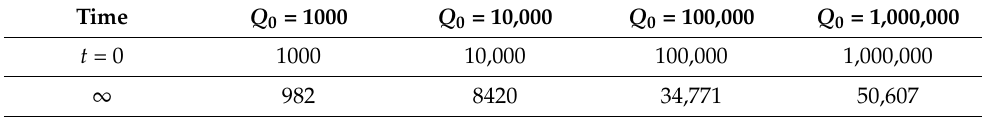
Table 11. Changes of different initial Q-factor with time during storage (T = 25 ◦